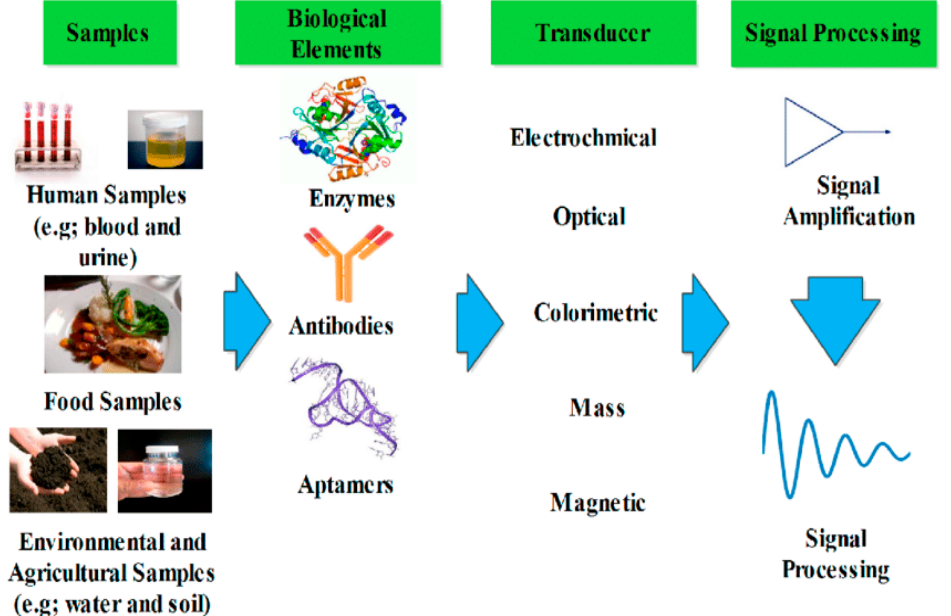
Figure 11. Schematic representation of biosensor (taken from [132]).